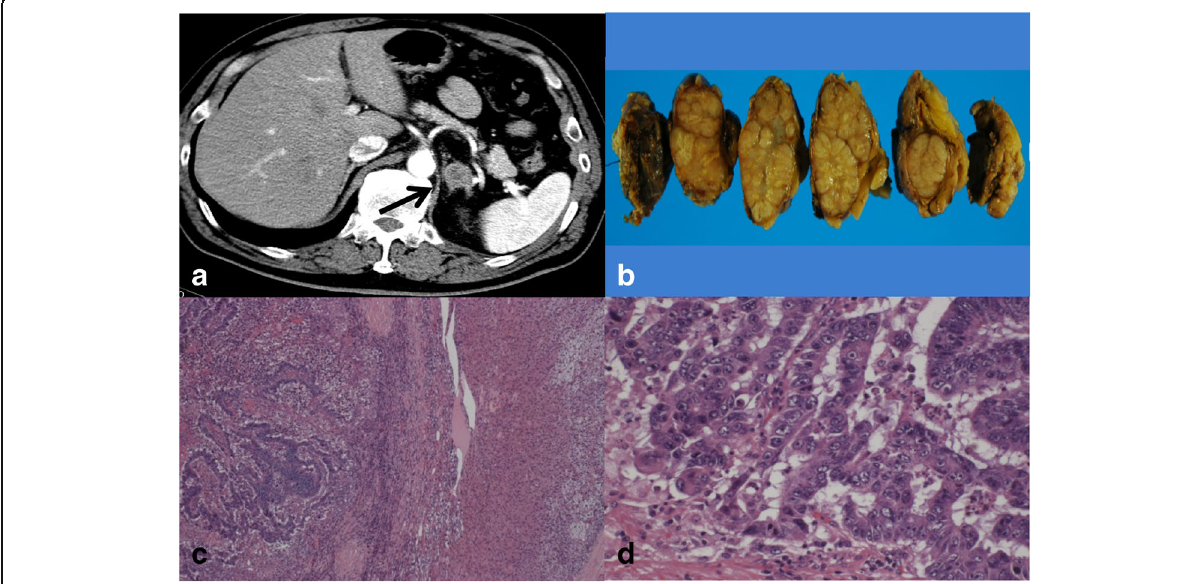
Fig. 3 The clinicopathological findings of Case 2. a The preoperative findings: Abdominal CT showed an enlarged left adrenal gland (black arrow). b The macroscopic appearance: The cross-section of the adrenal tumor was solid and grayish white. c , d The histopathological findings: The histopathological examination of the adrenal tumor showed adenocarcinoma, which was compatible with metastasis of primary colon cancer